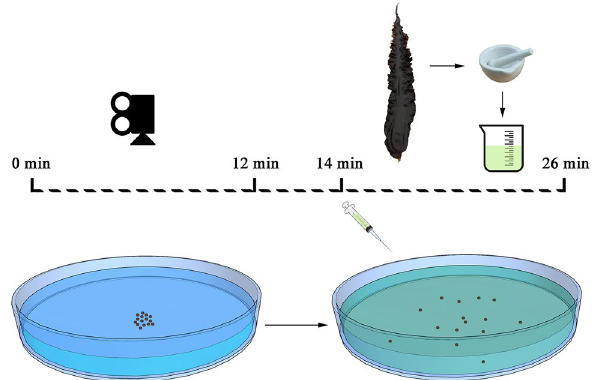
Figure 4. Diagram of the experiment. The period without the food cues was from 0 to 12 min, the period with the food cues was from 14 to 26